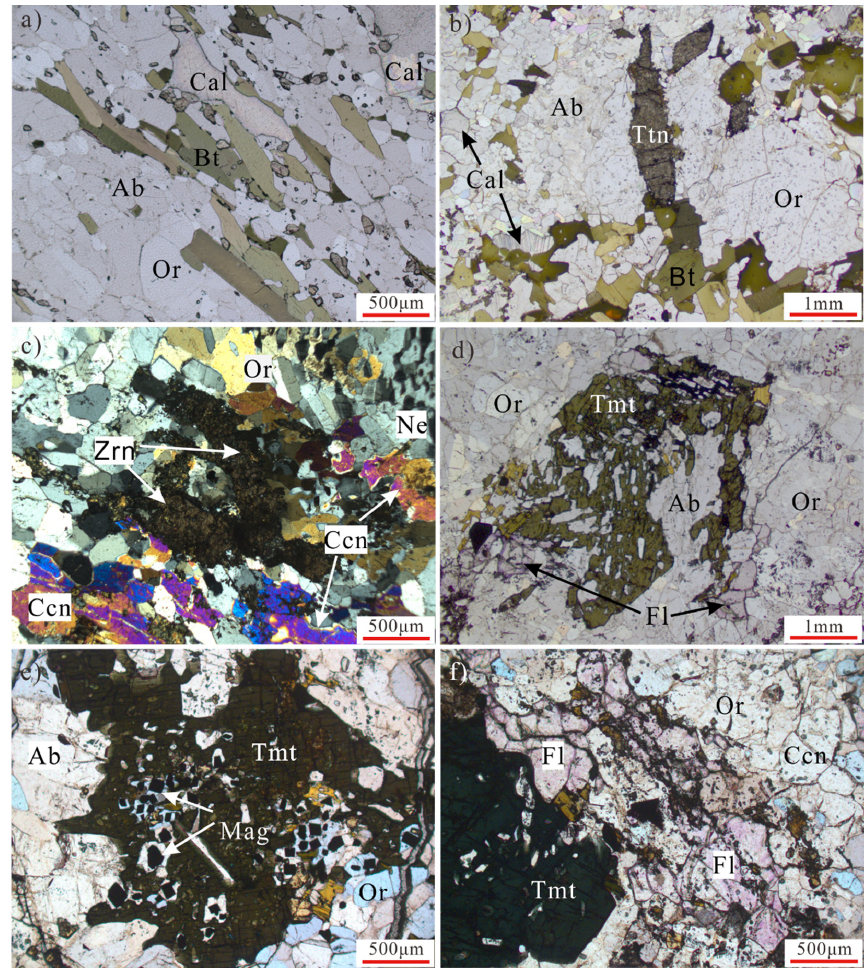
Figure 2. Petrography of the Shuangshan alkaline complex. ( a ) Sheet biotite. (Bt), orthoclase (Or), albite (Ab), and a small amount of calcite (Cal) in the fine-grained gneissic structure biotite syenite. ( b ) Envelope-shaped titanite (Ttn) in biotite syenite. ( c ) Nepheline (Ne), cancrinite (Ccn), orthoclase, and zircon (Zrn) aggregate in nepheline syenite (cross-polarized light). ( d ) Orthoclase, albite, subhedral fluorite (Fl), and taramite (Tmt) with a diablastic texture in nepheline syenite. ( e ) Subhedral taramite with magnetite (Mag) in it. The taramite is associated with orthoclase and albite in nepheline syenite. ( f ) Disseminated fluorite, cancrinite, orthoclase, and subhedral taramite in nepheline syenite.